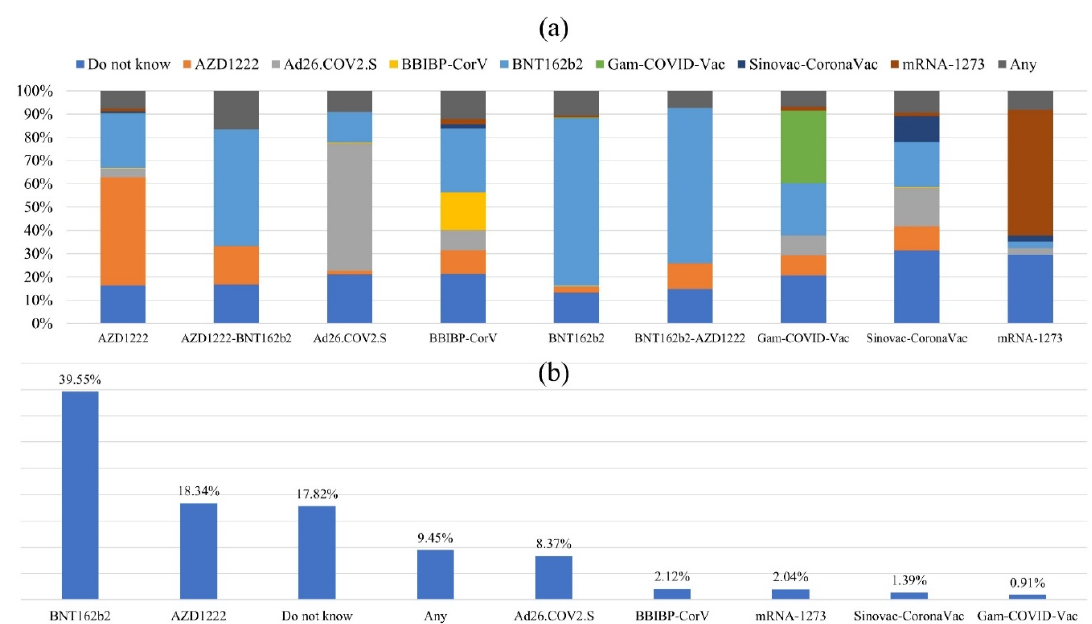
Figure 4. ( a ) The first choice of the specific COVID-19 vaccine booster dose among respondents earlier vaccinated with AZD1222, AZD1222-BNT162b, Ad26.COV2.S, BBIBP-CorV, BNT162b, BNT162b-AZD1222, Gam-COVID-Vac, Sinovac-CoronaVac, mRNA-1273, AZD1222, and Ad26.COV2.S ( n = 2302); ( b ) frequencies of top-selected booster doses regardless of the previously vaccinated dose ( n = 2306). Table 4. The univariate logistic of the significant predictors of accepting COVID-19 vaccine booster